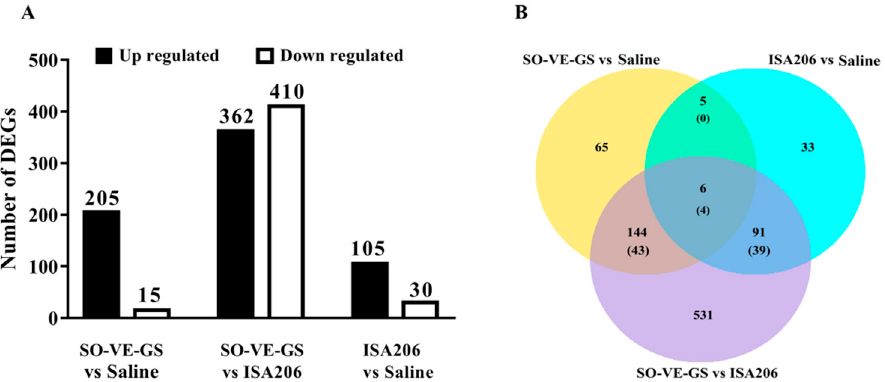
Figure 6. The numbers of di ff erentially expressed genes (DEGs). Mice ( n = 4 / group) were i.m. immunized twice at a 2-week interval with FMDV antigen in saline or adjuvanted with SO-VE-GS or ISA206. Splenocytes were isolated from the spleens harvested 2 weeks after the boost and used for transcriptome sequencing. ( A ) The histogram shows the numbers of up-regulated and down-regulated genes in three groups. ( B ) Overlap comparison of di ff erentially expressed genes enriched by GO analysis and the numbers of immune-related genes are in brackets.